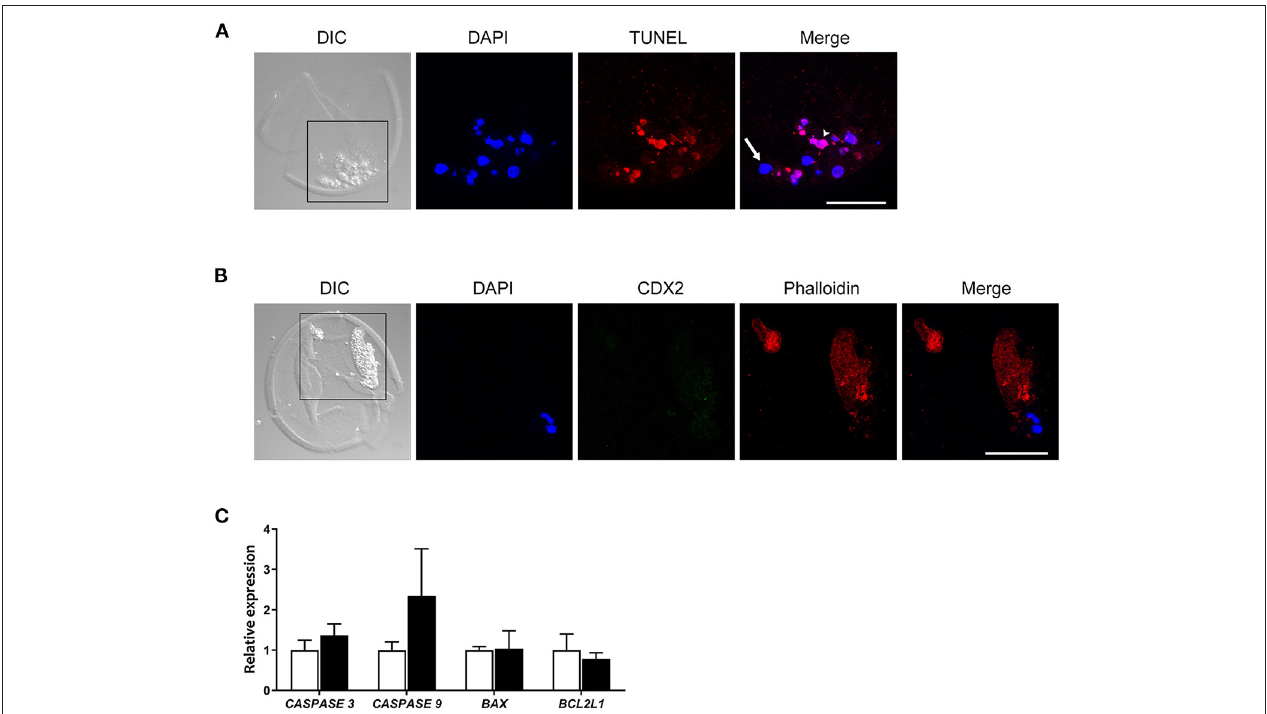
FIGURE 3 | CDX2 and Phalloidin immunofluorescent staining, and apoptosis related gene expression in cellular fragments in the perivitelline space of a day 9 bovine blastocyst. (A) TUNEL positive (red, arrowhead) and negative cells (arrow) are indicated in a day 9 blastocyst. Blue represents DAPI staining. (B) CDX2 and Phalloidin staining of cellular fragments in a day 9 blastocyst. Black boxes in (A,B) indicate the areas presented in the right at higher magnification. Scale bar = 50 µ m. (C) Relative expression of apoptosis-related genes -in day 9 blastocysts (white bars, n = 87) vs. fragmented cells (black bars, n = 151) as determined by qRT-PCR. Error bars indicate standard deviation of three biological replicates. DIC, differential interference